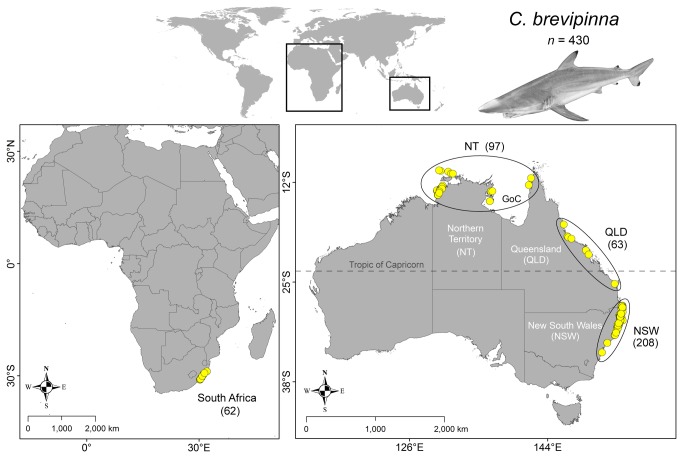
Collection locations for tissues included in genetic structure and diversity analyses.Sample numbers for each putative population are in parentheses. GoC = Gulf of Carpentaria.